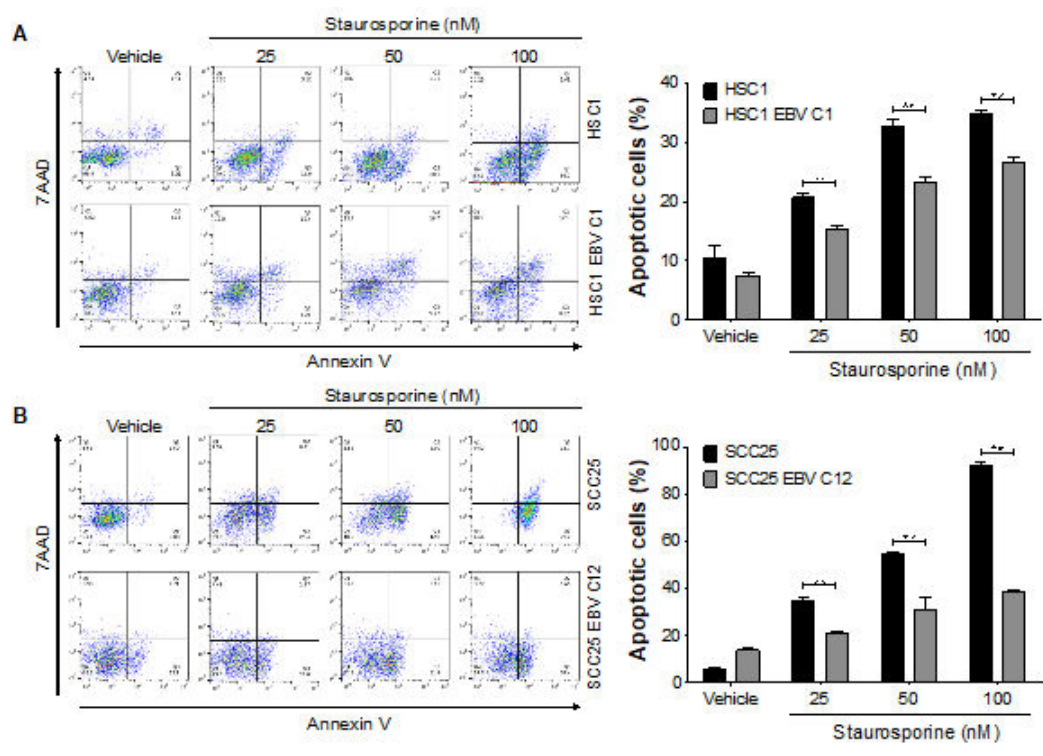
Figure 5. An anti-apoptotic e ff ect of EBV in SCC cells. Both EBV-positive and EBV-negative HSC1 cells ( A ) and SCC25 cells ( B ) were treated with staurosporine at 0, 25, 50 and 100 nM for 24 h. Apoptotic cells were quantified by flow cytometery. **: p <